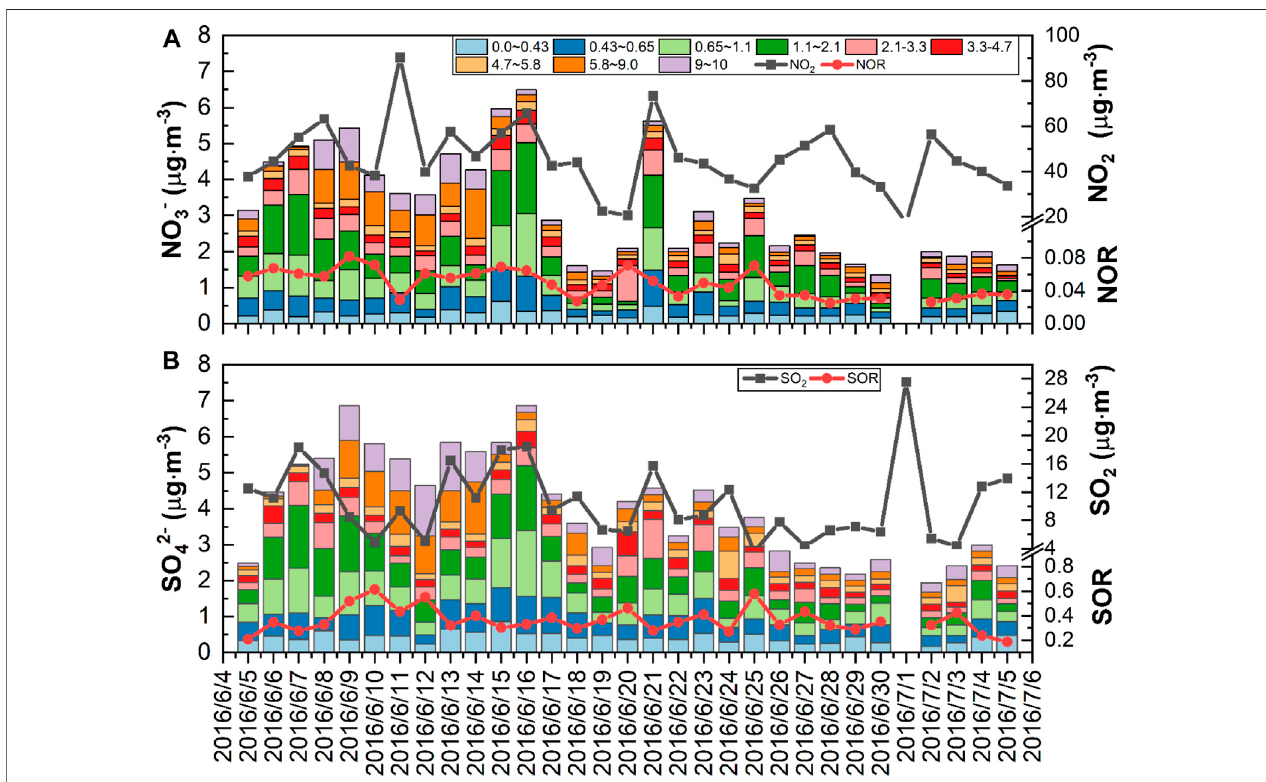
FIGURE 8 | Time series of (A) size distribution of NO 3 − , NO 2 concentration and NOR, and (B) size distribution of SO 42- , SO 2 concentration and SOR during the sampling period.